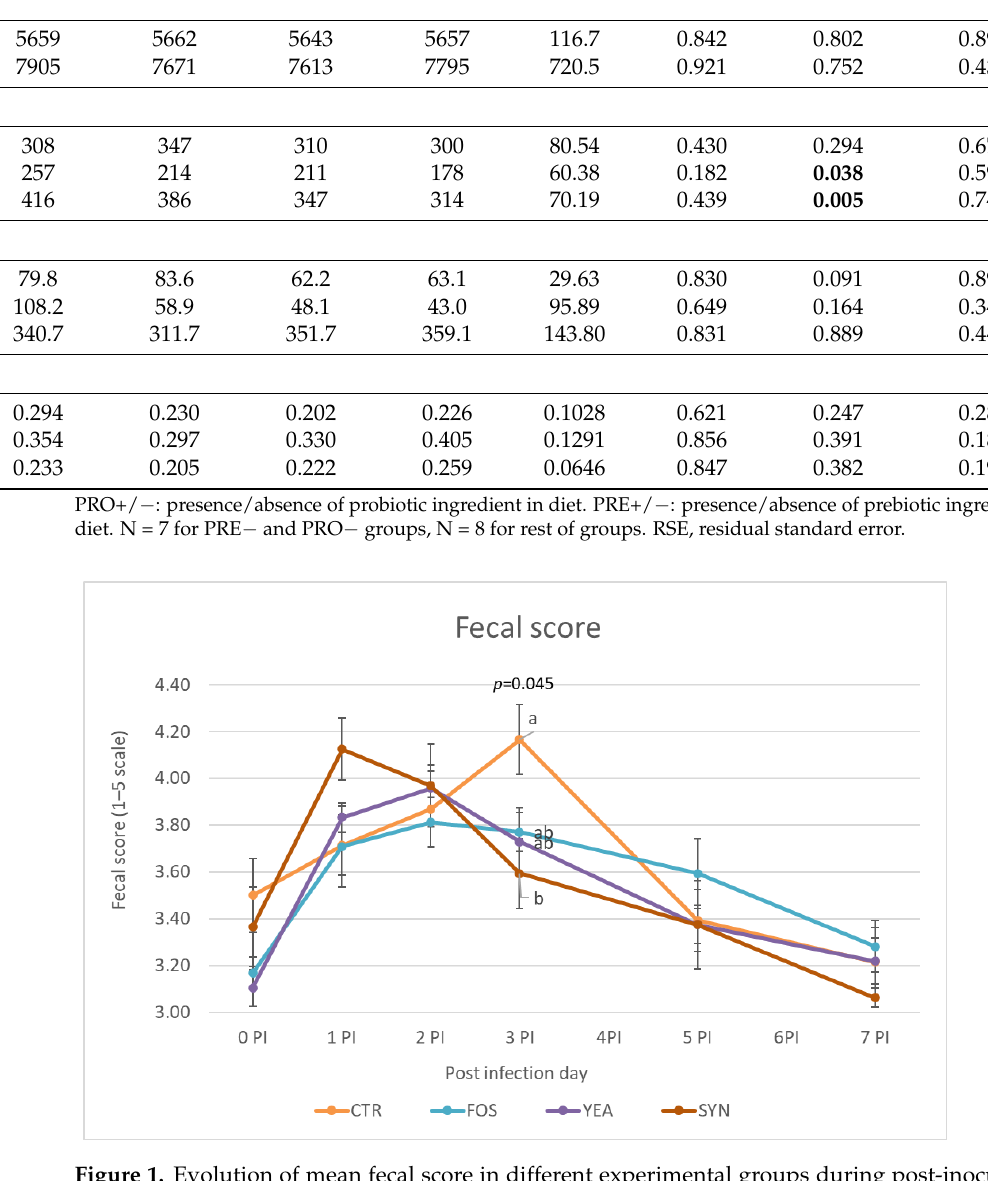
Figure 1. Evolution of mean fecal score in different experimental groups during post-inoculation period. CTR (in orange): animals receiving pre-starter basal diet; scFOS (in blue): animals receiving basal diet with short-chain fructo-oligosaccharides supplementation; YEA (in purple): animals receiving basal diet with Saccharomyces cerevisiae Sc 47 supplementation; SYN (in red): animals receiving both supplementations (scFOS + YEA). N = 7 for CTR group, N = 8 for rest of groups. a,b indicate statistically significant differences between groups.